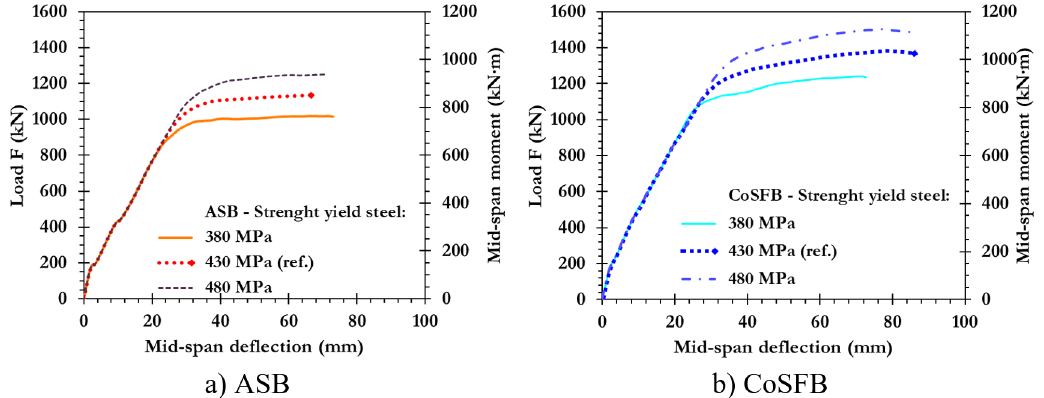
Figure 21. Load-deflection curve – Strength of steel